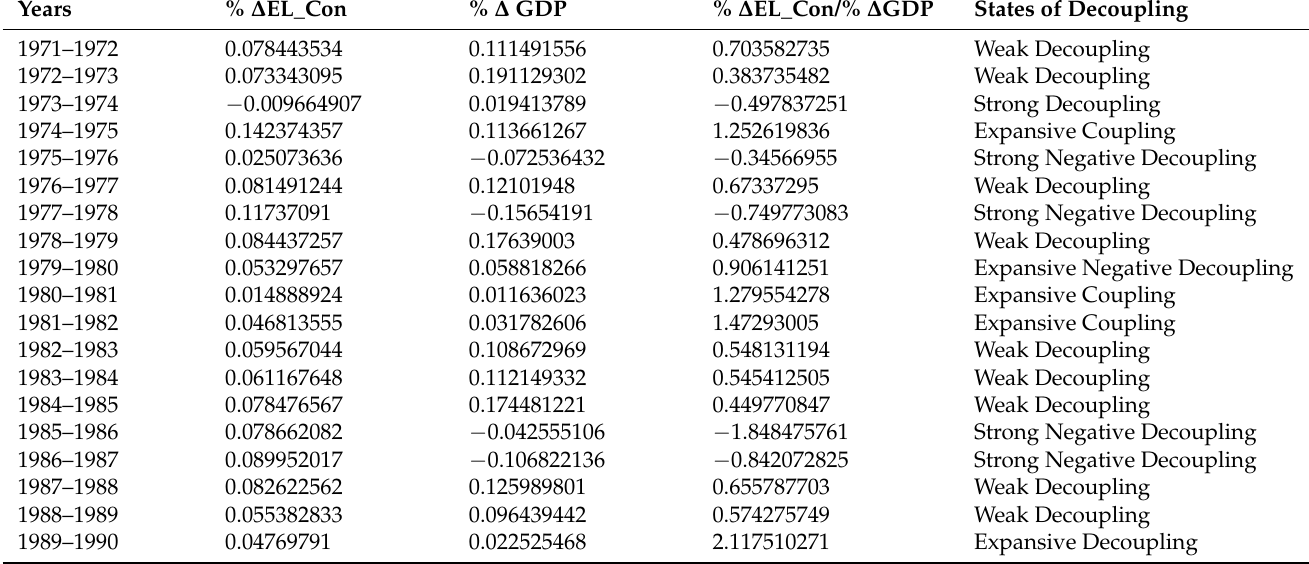
Figure 4. The CO 2 emissions trend for the economy of China for the period 1971–2020. Table 4. The states of decoupling of electricity consumption total and GDP in China during